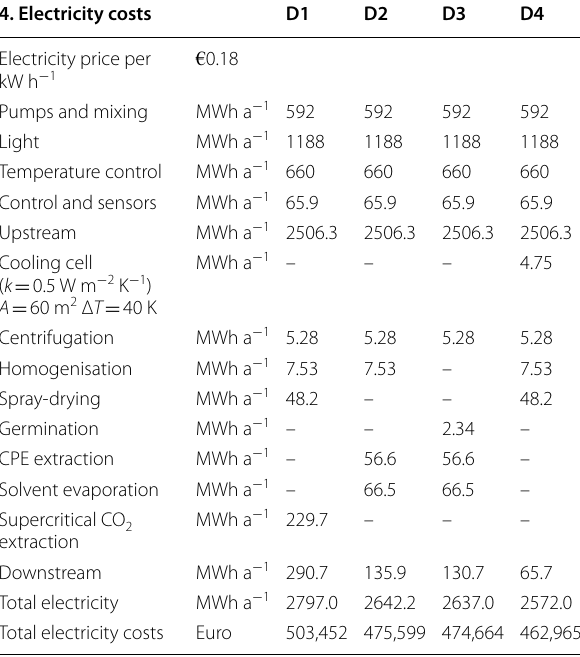
Table 8 Annual electricity costs of the biotechnological production of H. pluvialis , comparing four different downstream scenarios, D1, D2, D3, and